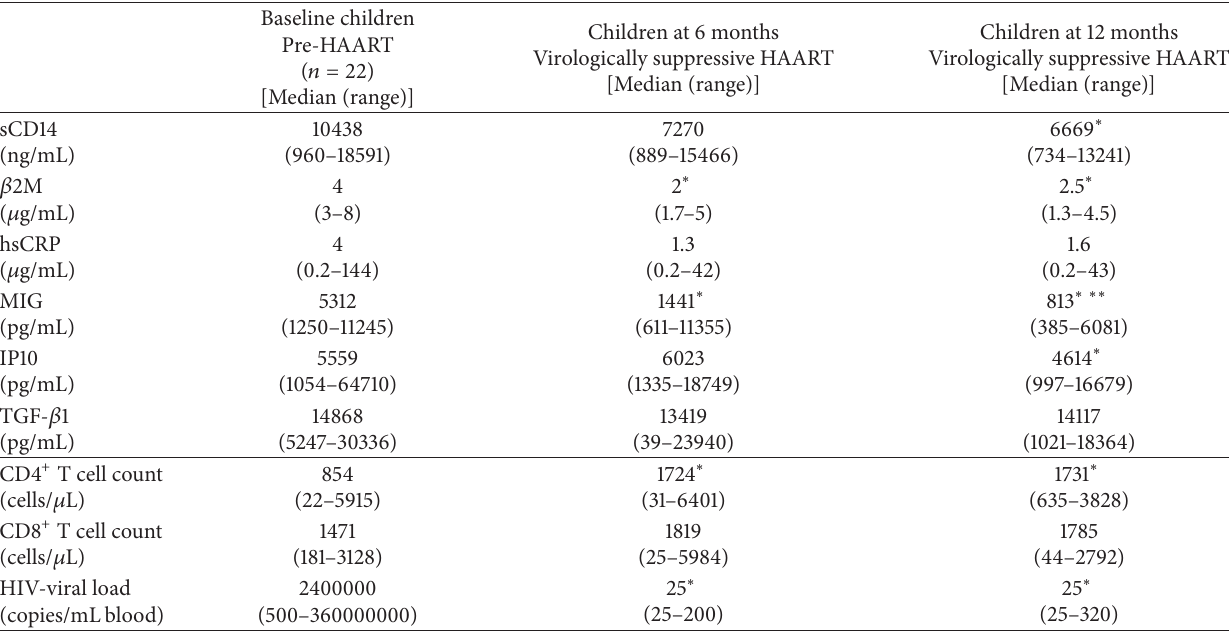
Table 3: Longitudinal follow-up of a subgroup of the